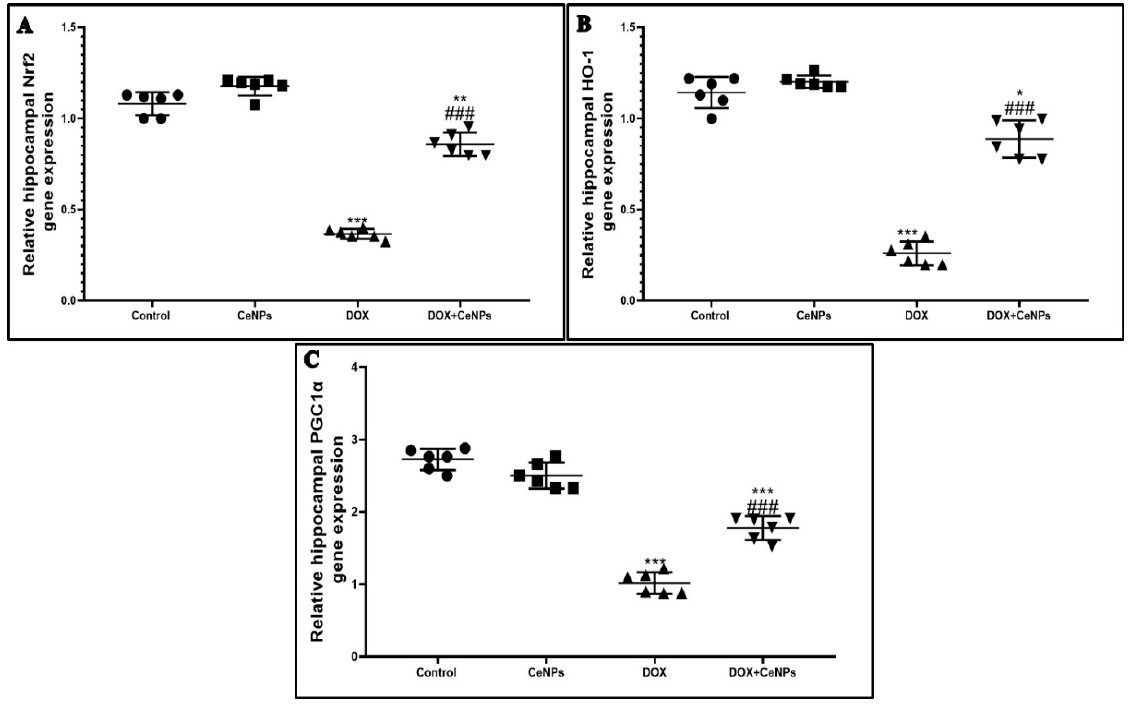
Figure 2. Effect of nanoceria treatment on relative gene expression of antioxidant genes. ( A ) Nrf2, ( B ) HO-1 and ( C ) PGC1- α in different groups of rats. All data were expressed as mean ± SD, (one-way ANOVA test followed by Tukey’s post hoc test, *** p < 0.001, ** p < 0.01 and * p < 0.05 vs. control